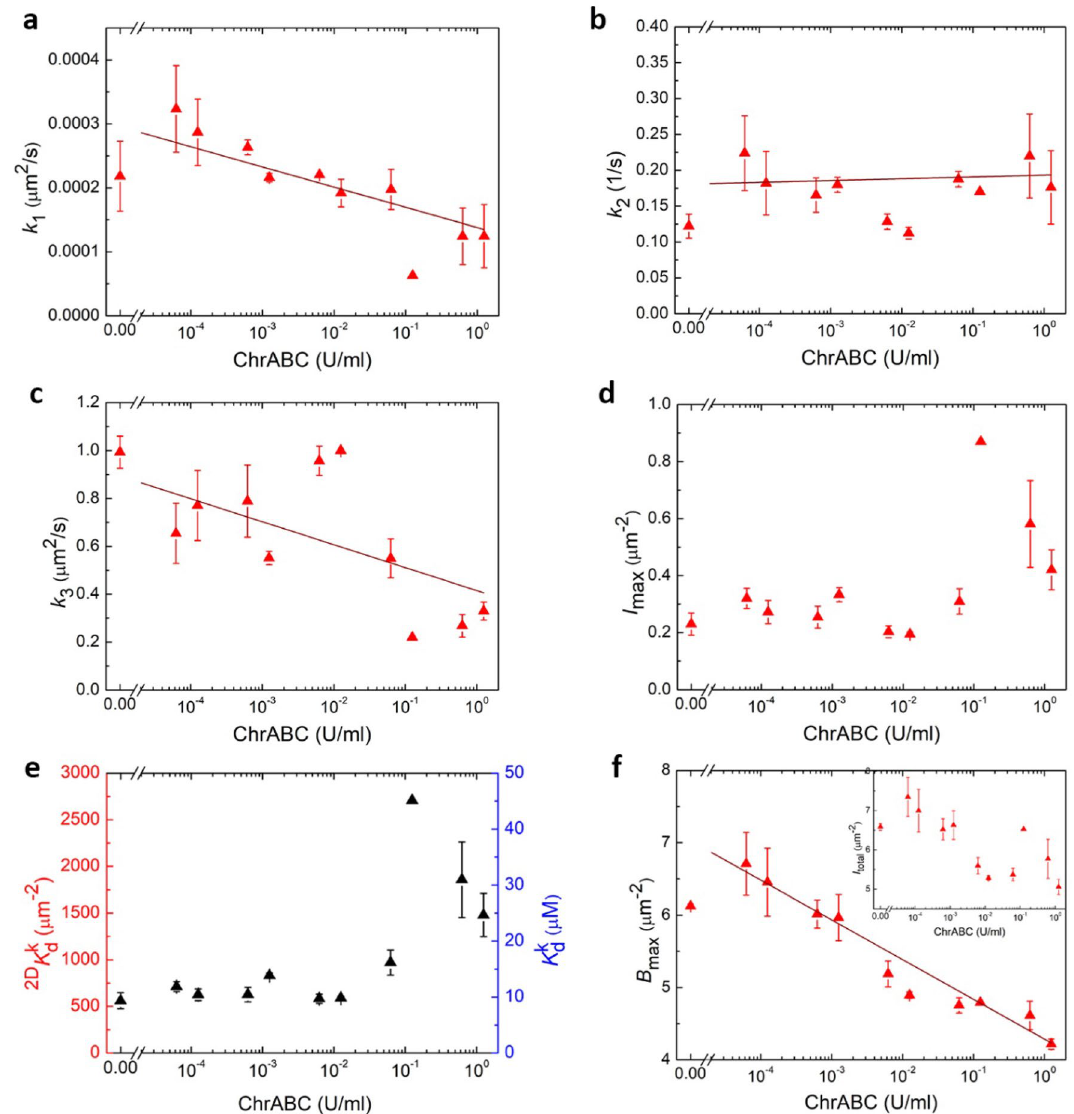
Figure 8. ( a – d ) The resulted k 1 , k 2 , k 3 and I max parameters from the model fitted to the the data at 11 enzyme concentrations. ( e ) The 2D kinetic dissociation constant, 2D K k d , and the 3D “kinetic” dissociation constant, K k d , calculated using the kinetic parameters from the fit. ( f ) Bound integrin-ligand complex surface concentration at saturation, and in Inset: the total number of integrins at saturation, in the function of enzyme 2D dissociation constant by the average cell–substrate separation distance ( d c ) (the thickness of the confinement zone) according to Eq. (5) 5,61 .